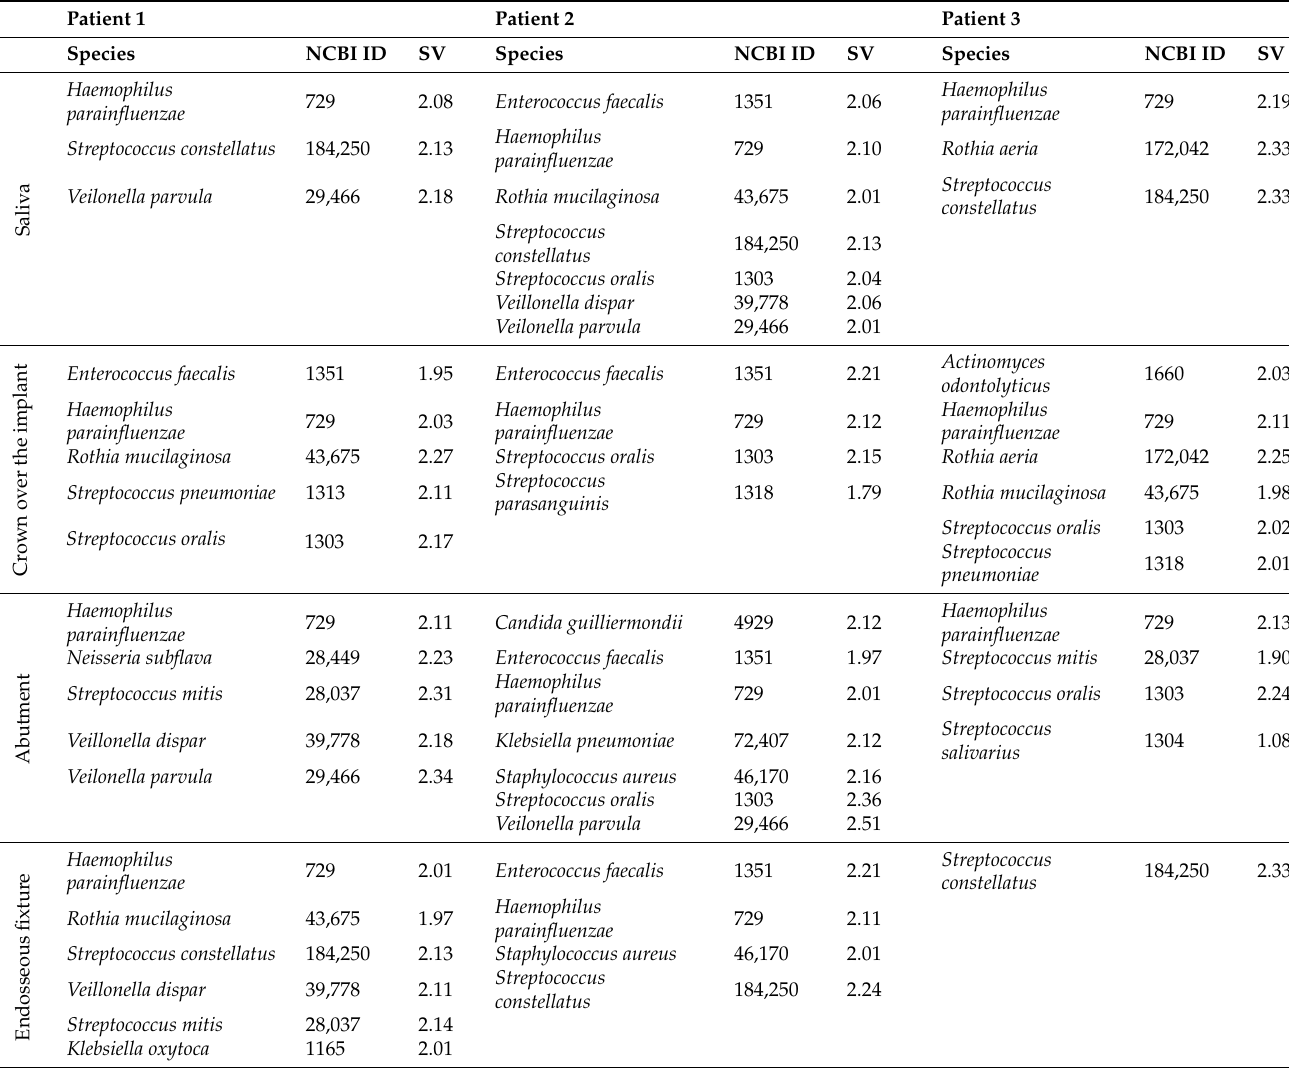
Table 1. Microorganisms identified with MALDI-TOF MS on individual surfaces of the dental implant and crown as well as in the saliva of patients diagnosed with